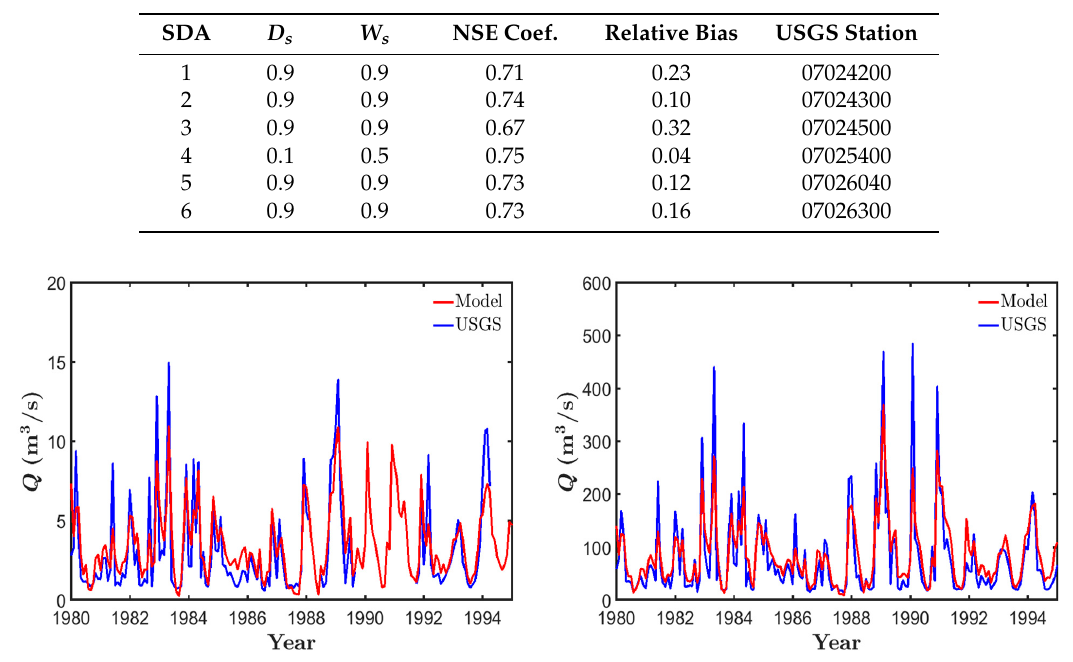
Figure 6. Calibration of monthly streamflow fluxes for two sub-drainage areas (SDA): ( left ) SDA 2 and ( right ) SDA 5.